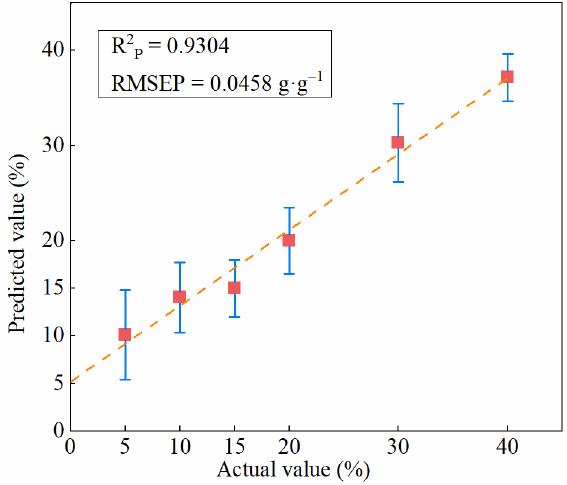
Figure 6. The result in prediction set of the SSA-SVR with error bar.